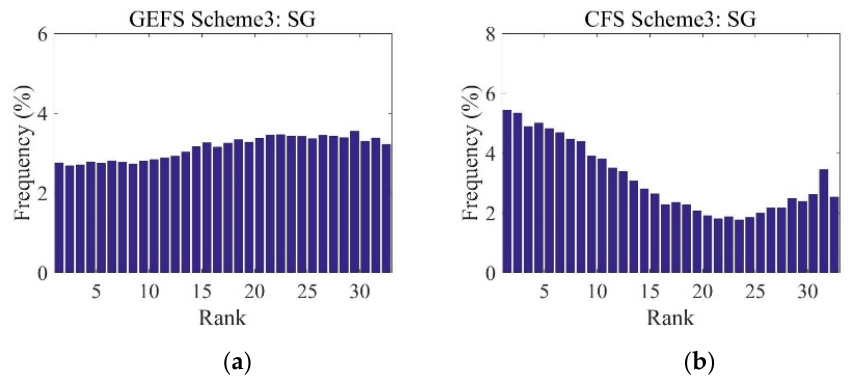
Figure 9. RHs of Shaoguan under the Scheme 3: ( a ) GEFS; and ( b ) CFSv2.